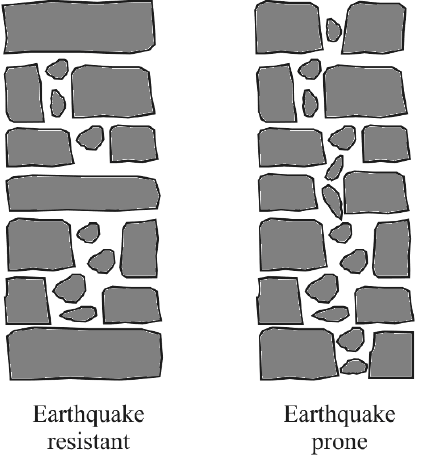
Fig. 8. Typical cross sections of earthquake resistant and fragile stone masonry walls.